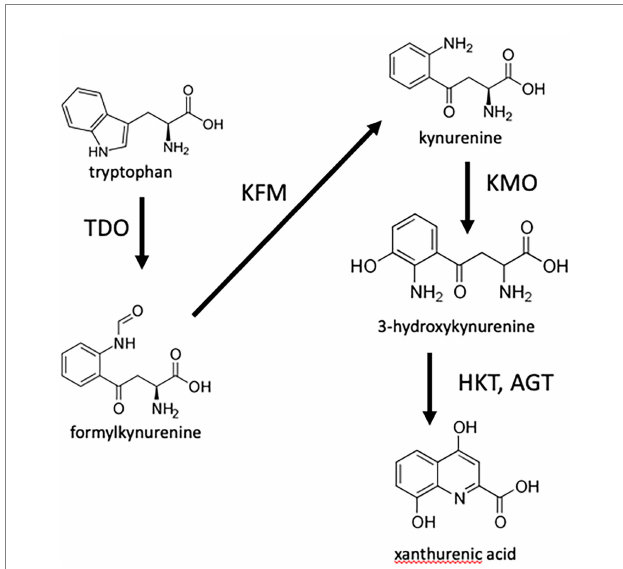
FIGURE 1 Initial steps in the biosynthesis of 8-HQA. Tryptophan is converted to formylkynurenine by tryptophan dioxygenase, which is then converted to kyurenine by kynurenine formamidase. Kynurenine in turn is converted to 3-hydroxykynurenine by kynurenine monooxygenase (KMO). The toxic 3-hydroxykynurenine is converted to xanthurenic acid by transamination (here shown via alanine glyoxalate aminotransferase, represented by two enzymes AGT1 and AGT2 encoded by separate genes in Spodoptera littoralis ) followed by cyclization. Labelling experiments have shown that 3-hydroxykynurenine is a precursor of 8-HQA (Pesek et al., 2015) therefore enzymes involved in its synthesis and conversion were targeted by